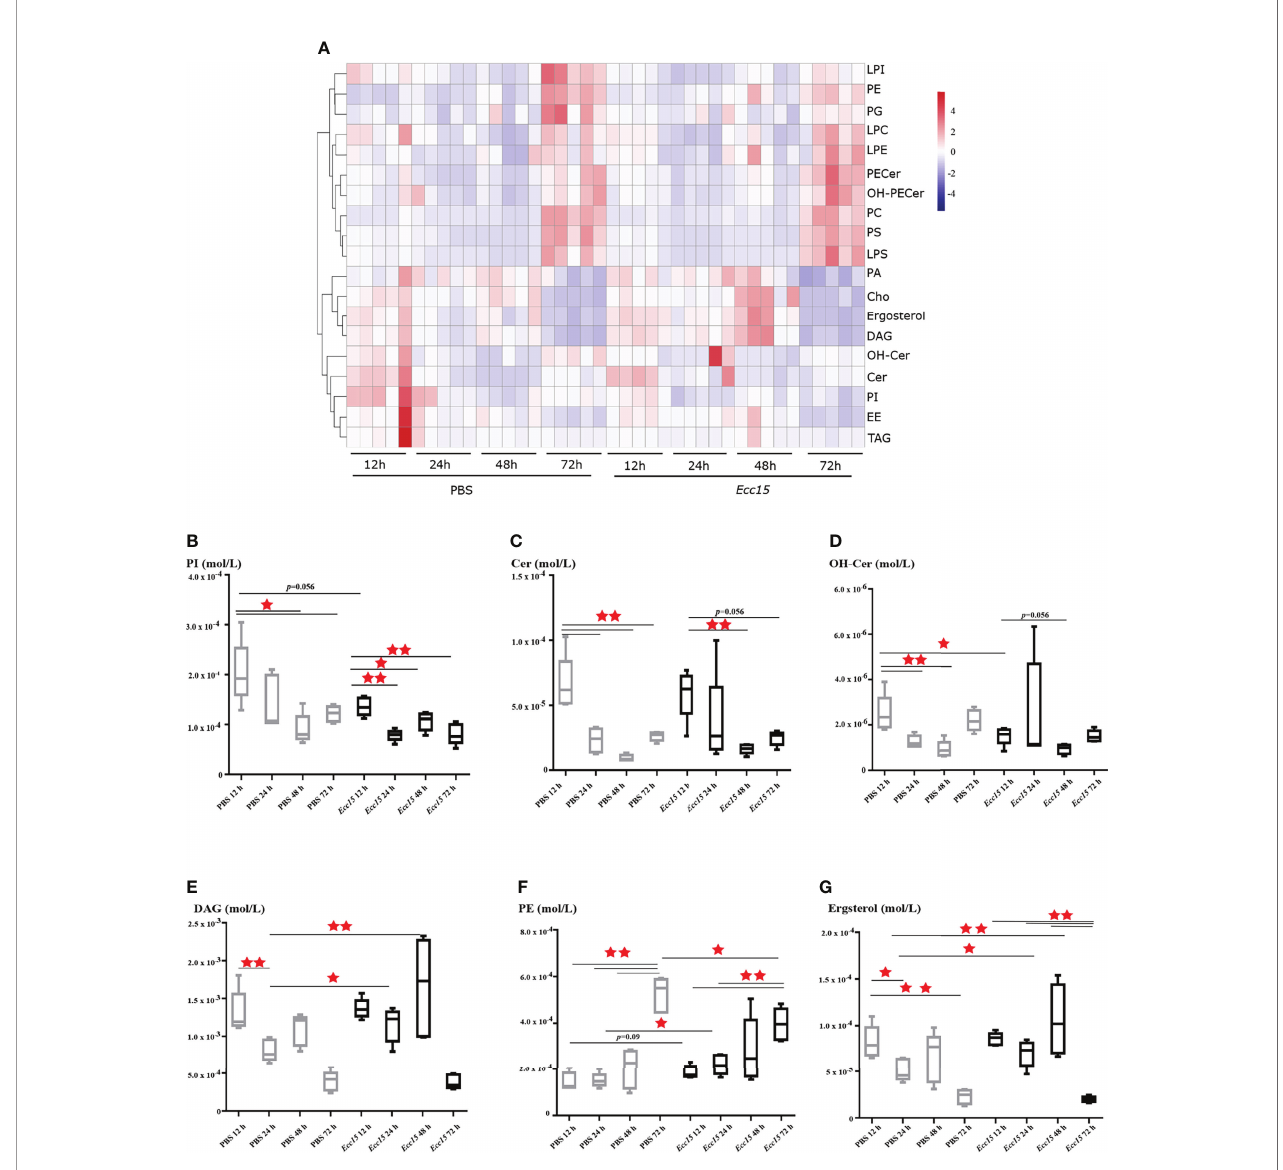
FIGURE 1 | Time-course lipidomic pro fi ling of Drosophila hemolymph after Ecc15 infection reveals a dynamic remodeling of lipid pro fi les. (A) . Heatmap for selected lipid species pro fi les at indicated time points (12, 24, 48, 72 hpi) in control (PBS) and Ecc15 -challenged ( Ecc15 ) fl ies. 5 duplicates were performed for each group. (B – G) . Box-plot of phosphatidylinositols (PI) (B) , Ceramides (Cer) (C) , Hydroxyceramide (OH-Cer) (D) , Diacylglycerols (DAG) (E) , Phosphatidylethanolamines (PE) (F) , ergosterol (G) at indicated time points (12, 24, 48, 72 hpi) in control (PBS) and Ecc15 -challenged ( Ecc15 ) fl ies. *, p<0.05; **, p<0.001. (wilcox